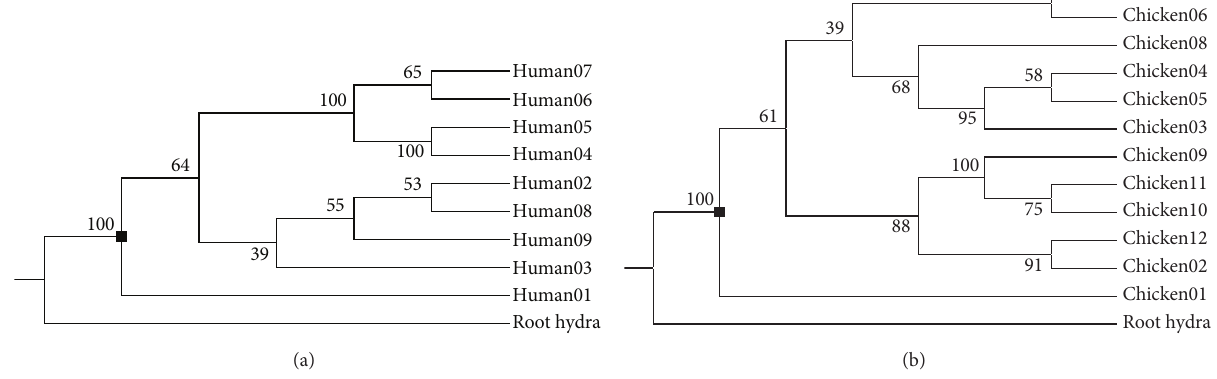
Figure 2: (a) Fitch-Margoliash tree for all rhodopsin genes in human. (b) Fitch- Margoliash tree for all rhodopsin genes in chicken. Hydra rhodopsin gene serves as outgroup. The numbers adjacent to tree nodes are bootstrap values. The tree node where ancestral state is built on is marked with a filled black square (cid:2)